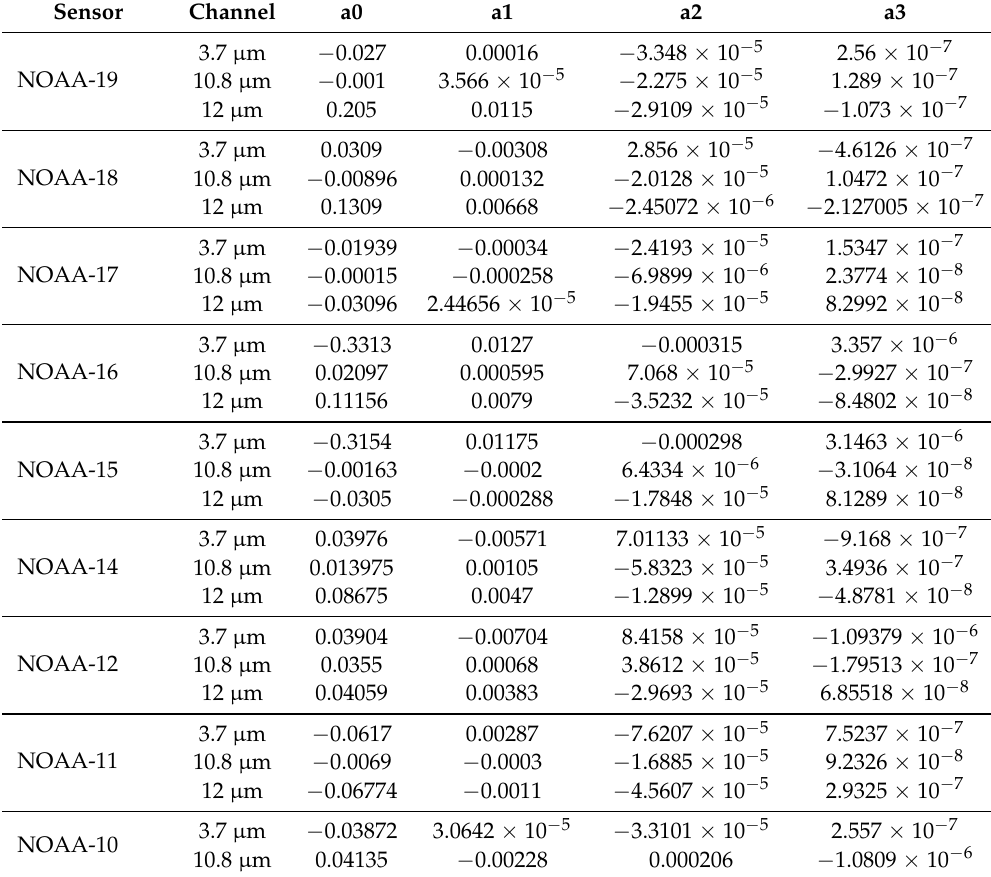
Figure 4. MetOp-A minus NOAA AVHRR brightness temperatures in the 3.7, 10.8 and 12 µ m channels plotted as a function of total column water vapour (TCWV) using RTTOV v11.3 simulations under clear-sky conditions. Results are binned in 1 kg m − 2 TCWV, with joined points showing actual data for an atmospheric path length of 1. Solid lines show a cubic fit to these data and dashed lines show a cubic fit for the differences for each AVHRR simulated using an atmospheric path length of 1.8. Data are not shown for the atmospheric path length of 1.8 for clarity. Table 4. Cubic coefficients for AVHRR MetOp-A minus AVHRR sensor differences simulated using RTTOV v11.3 for an atmospheric path length of 1.0. Coeffiecients are a function of total column water